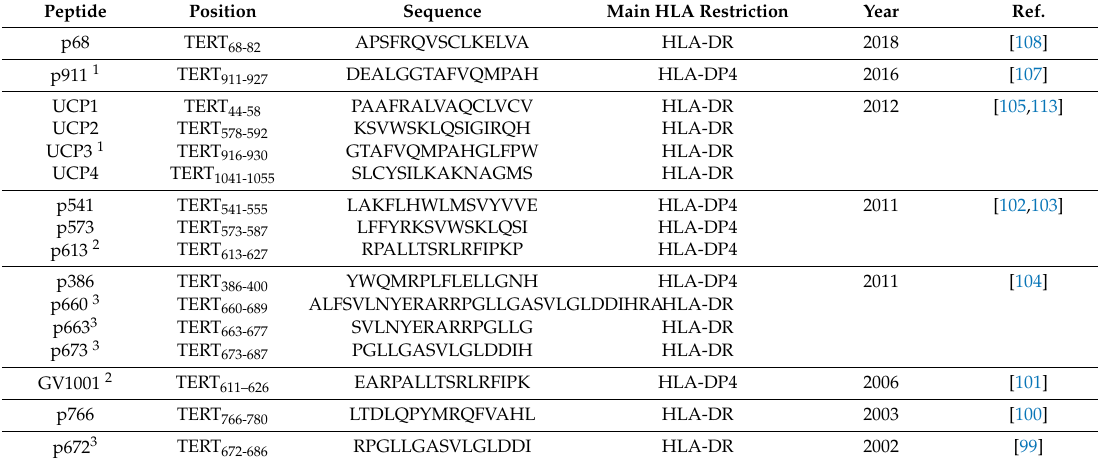
Table 1. List of identified immunogenic TERT CD4